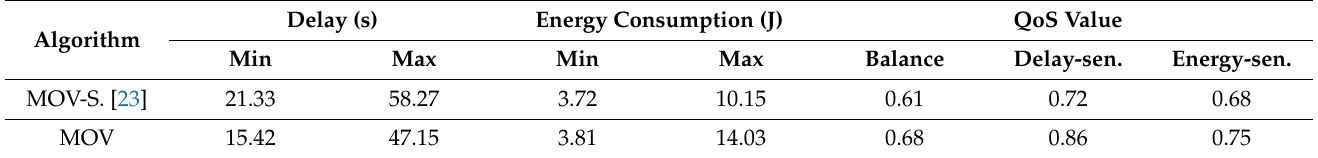
Table 5. Values of different indicators compared with